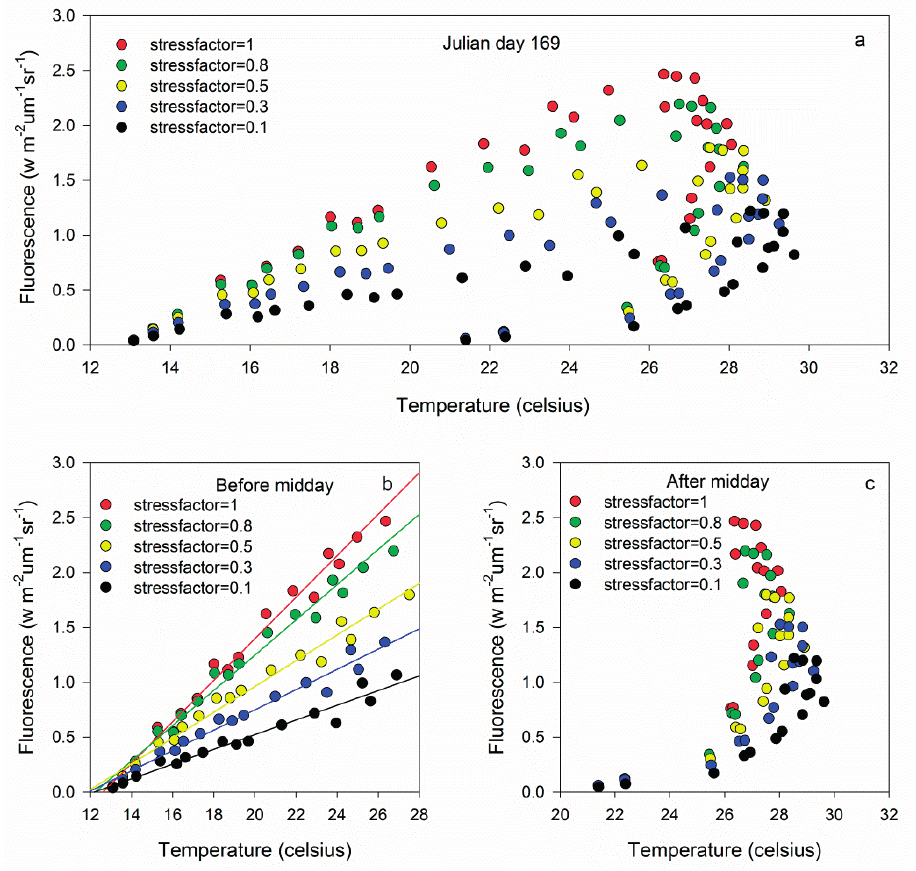
Figure 2. Relationships between the fluorescence and canopy temperature: ( a ) Full day, ( b ) before midday and ( c ) after